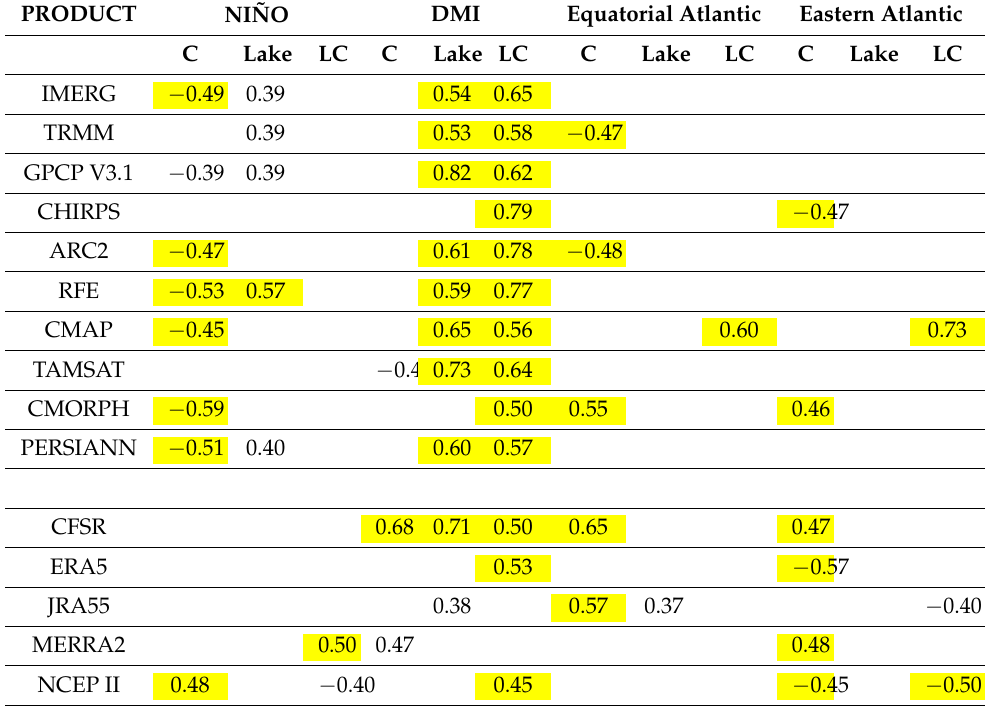
Table 5. Correlations between rainfall estimates from satellite and reanalysis products and indicators of potential large-scale factors: Niño is SSTs from the Niño 3.4 region; equatorial Atlantic and eastern Atlantic are also SSTs. DMI is the Dipole Mode Index. Locations for these are shown in Figure 2. C = Congo, LC = Lake catchment; these regions are shown in Figure 1. Only correlations reaching at least the 10% significance level are indicated. Those highlighted in yellow exceed the 5% significance